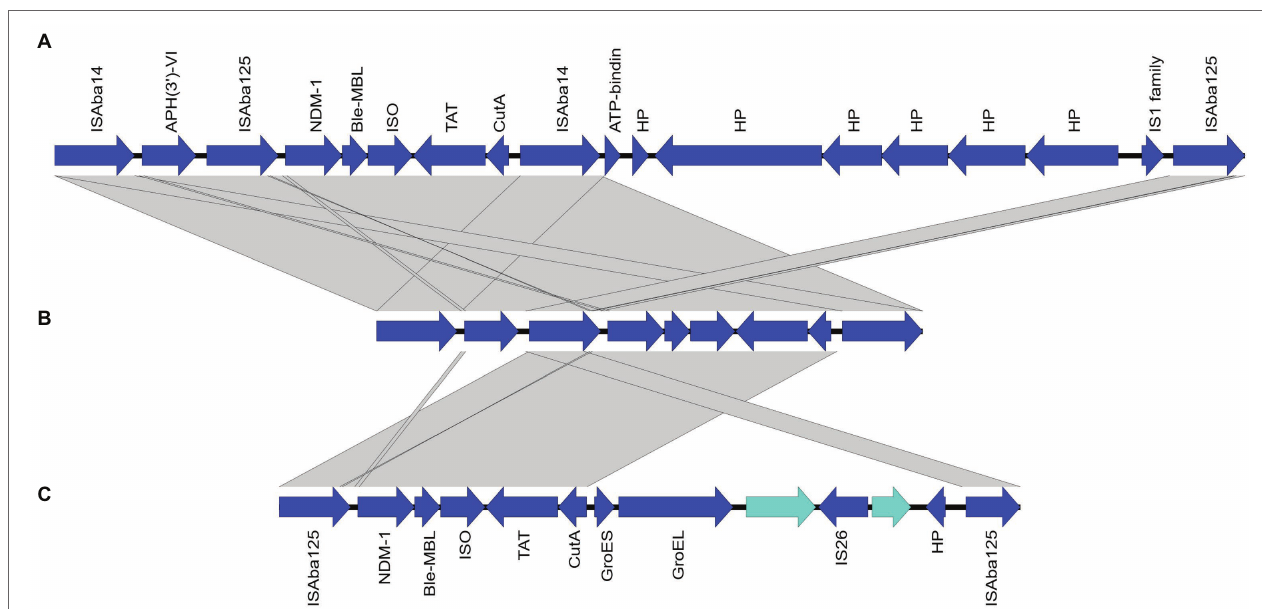
FIGURE 4 | Graphical representation of bla NDM-1 genetic environment in isolates M02 and M11 (B) compared to the closest match sequence Tn 125-like transposon of A. baumannii strain ACN21 (GenBank accession: CP038644.1) (A) and Tn 125 (GenBank accession: KF702386.1) (C) . ORFs orientation is indicated by arrows. Grey bands between panels indicate more than 98% sequence similarity. Genes are labelled by their protein products; NDM-1, New Delhi metal-beta-lactamase enzyme; ble-MBL, bleomycin resistance protein; ISO, phosphoribosylanthranilate isomerase; TAT, twin-arginine translocation pathway signal sequence protein; CutA, divalent cation tolerance protein; HP, hypothetical protein; GroES, co-chaperonin protein; GroEL, type I